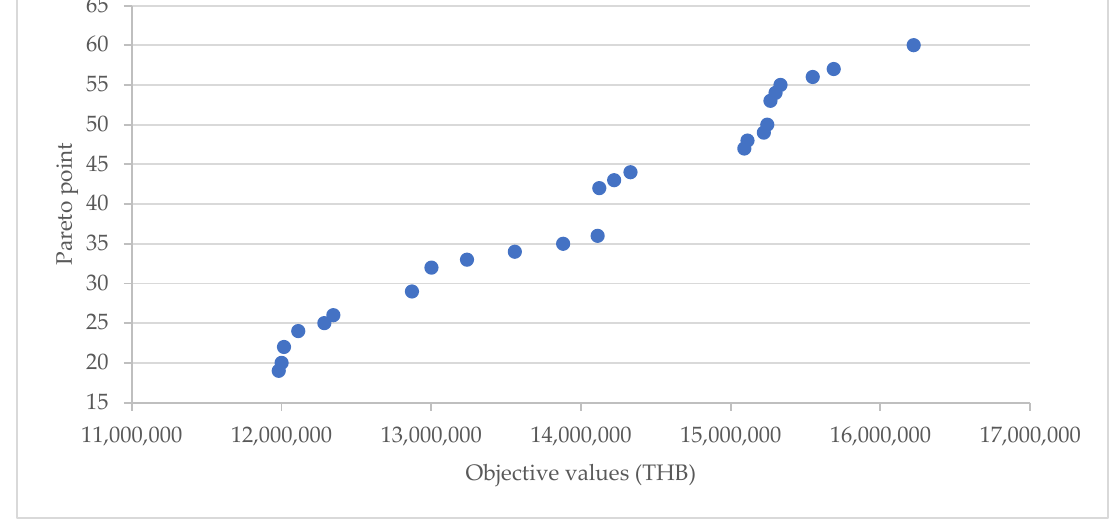
Figure 7. Pareto front of DE.